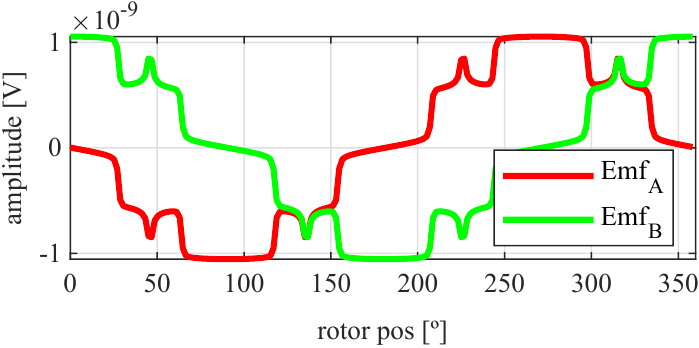
Figure 17. Toroidal four-slot resolver EMFs with the least THD.